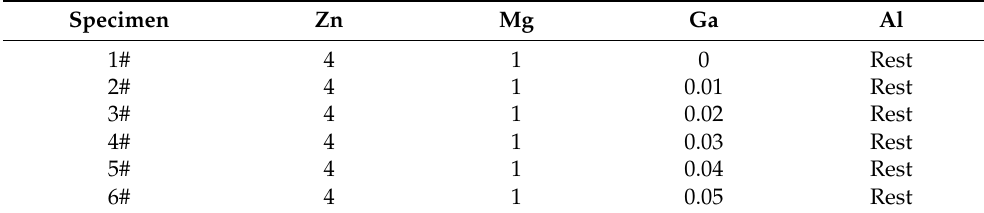
Table 1. The composition of Al-Zn-Mg-Ga aluminum sacrificial anodes (wt%). Specimen Zn Mg Ga Al